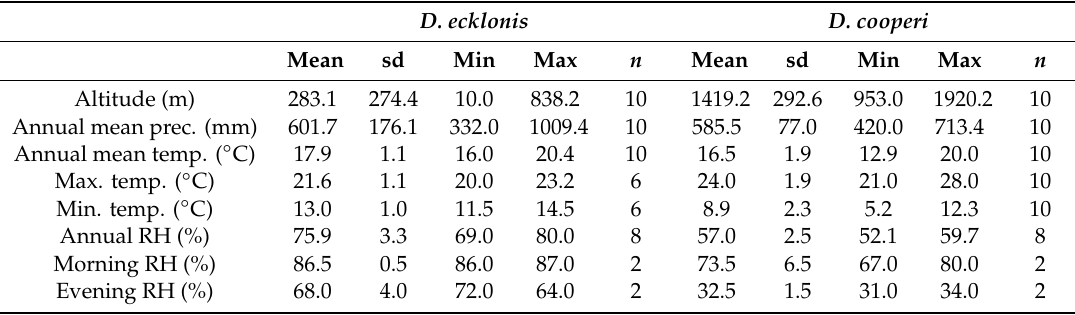
Table A1. Climate data acquired on the basis of occurrence data of the natural habitats of D. cooperi and D. ecklonis . The mean value, standard deviation (sd), minimal (min) and maximal (max) values and number of acquired climate data ( n ) are given for the altitude of occurrence (m), the annual mean precipitation (mm), the annual mean temperature ( ◦ C), the annual minimal and maximal temperature ( ◦ C), the annual relative humidity (RH in %) and daily fluctuations of the RH (morning and evening RH) of each species. The climate data for a given city originates from an average of 18–112 years on record for each city of occurrence of each species.